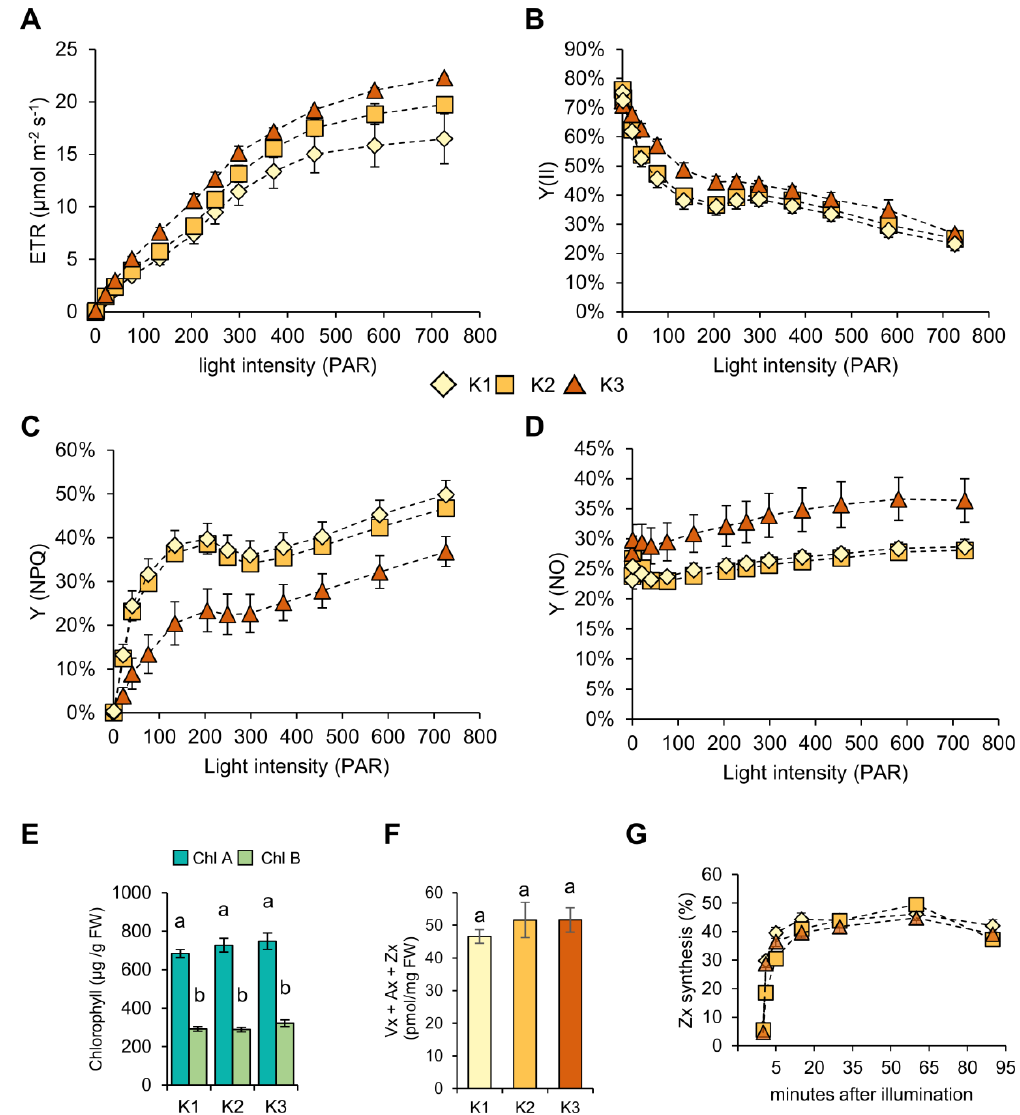
Figure 3. Effect of different soil K levels on photosynthetic parameters and photosynthetic pigments. ( A ) Electron transfer rate (ETR) describing how many electrons were generated from the collected photons at photosystem II, depending on the light intensity. ( B ) Quantum yield of photosynthesis [Y(II)], depending on the light intensity. ( C ) Non-photochemical quenching [Y(NPQ)], depending on the light intensity. ( D ) Non-regulated quenching [Y(NO)], depending on the light intensity. ( E ) Chlorophyll A and B contents of leaves. ( F ) Summarized content of violaxanthin (Vx), antheraxanthin (Ax), and zeaxanthin (Zx). ( G ) Zeaxanthin synthesis ( = Zx / (Vx + Ax + Zx) × 100%) after transfer of leaves from dark to high light (750 µ E). Four plants were analyzed per condition. Data points are means ± SE. Light curves were recorded using continuous light, incrementally increasing data in ( F – G ) are means from n = 5 replicates ± SE. Di ff erent letters above bars indicate significant di ff erences, according to one-way ANOVA with post-hoc Tukey HSD test ( p <